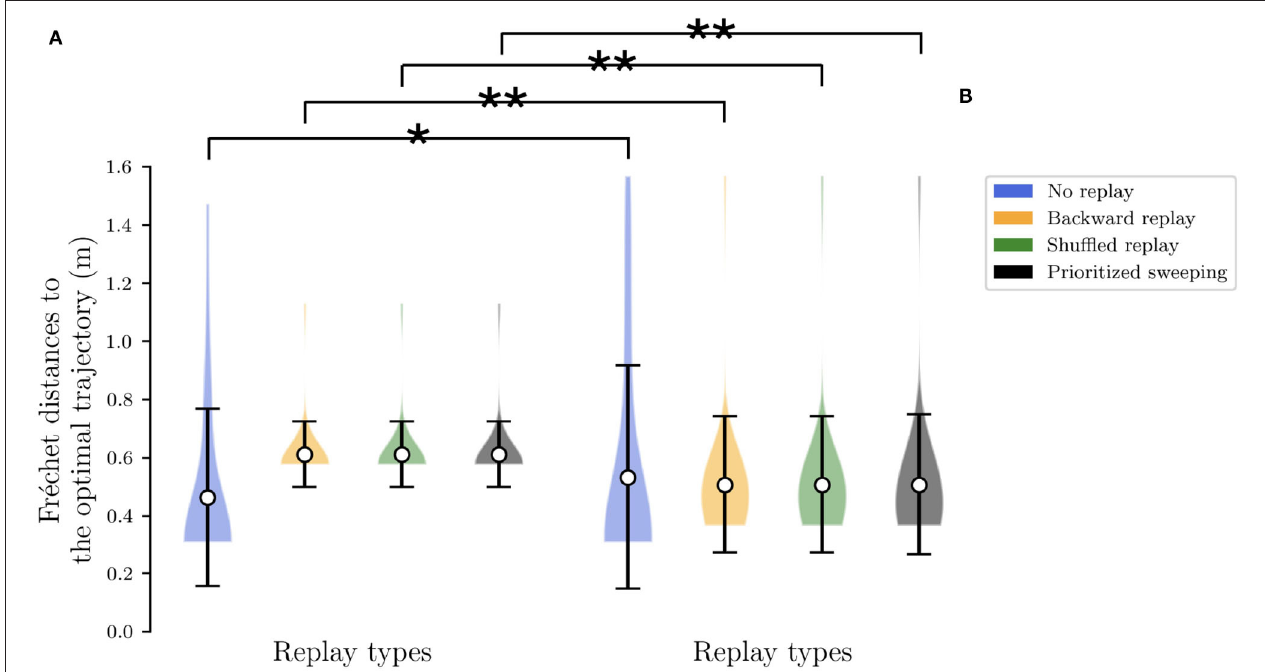
FIGURE 3 | Analysis to investigate the level of the sparsity of the explored trajectories by the agent. The Fréchet distance has been computed for the first half of the simulation. ** Stands for p -value lower than 0.001 and * for p -value lower than 0.05. (A) The extension of the Fréchet distance to the optimal trajectory in the deterministic case for all the algorithms. (B) The same extension of Fréchet distance in the stochastic